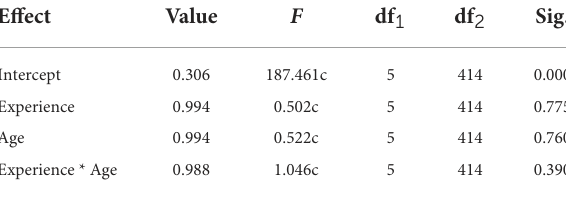
TABLE 2 Multivariate results for players on the contribution of age and years of experience on organizational